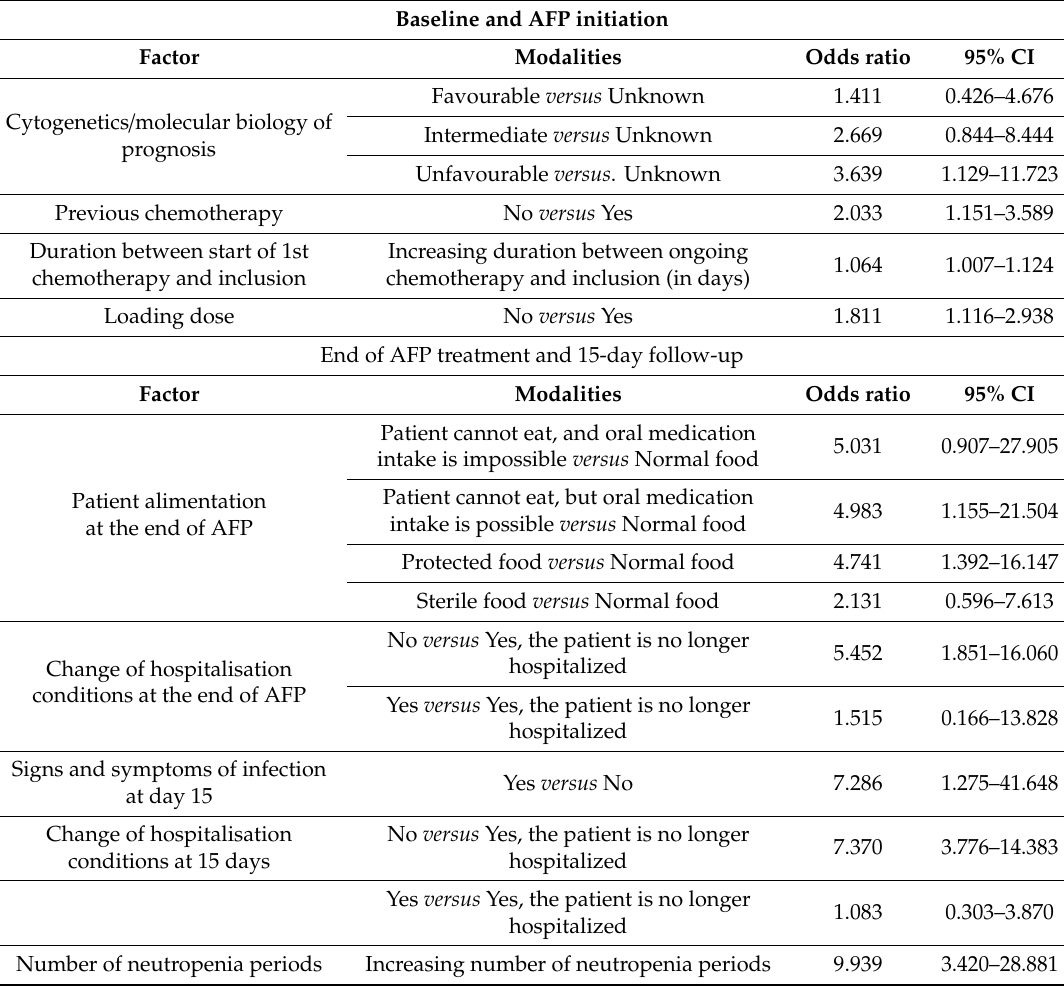
Table 7. Multivariate logistic regression of significantly di ff erent parameters at baseline, AFP initiation, end of AFP treatment and 15-day